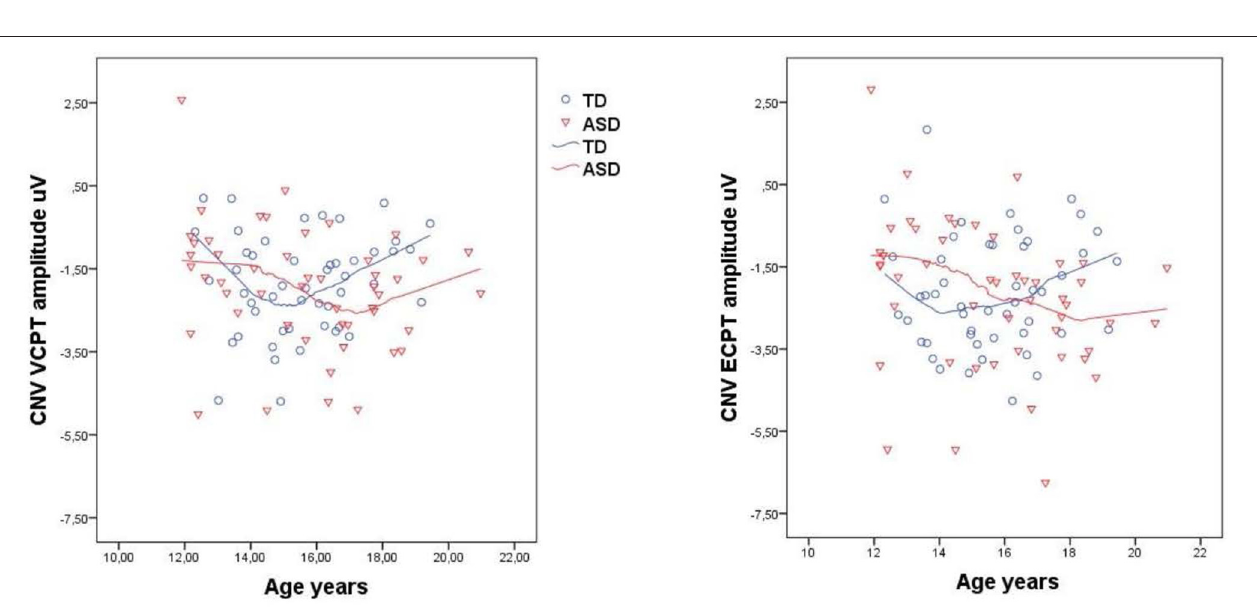
FIGURE 3 | Box plot of Contingent Negative Variation, CNV, in VCPT/ECPT. Mean CNV VCPT and ECPT increases from young to old in TD, decreases in ASD, giving a significant age-group × diagnosis interaction.